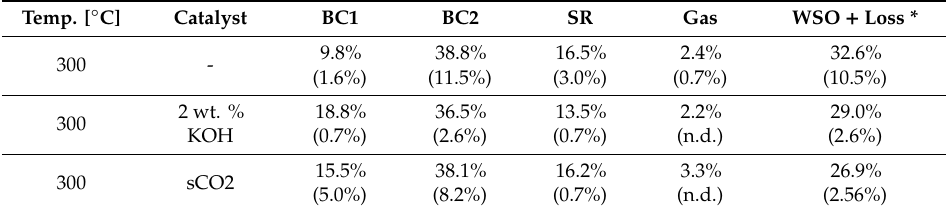
Table 5. E ff ect of CO 2 acid catalyzed reaction compared to base catalyzed and control test at 300 ◦ C, 5 min and 10 wt. % B / W: mass yields of BC1, BC2, SR, Gas, and WSO + loss. Absolute standard deviation is reported in